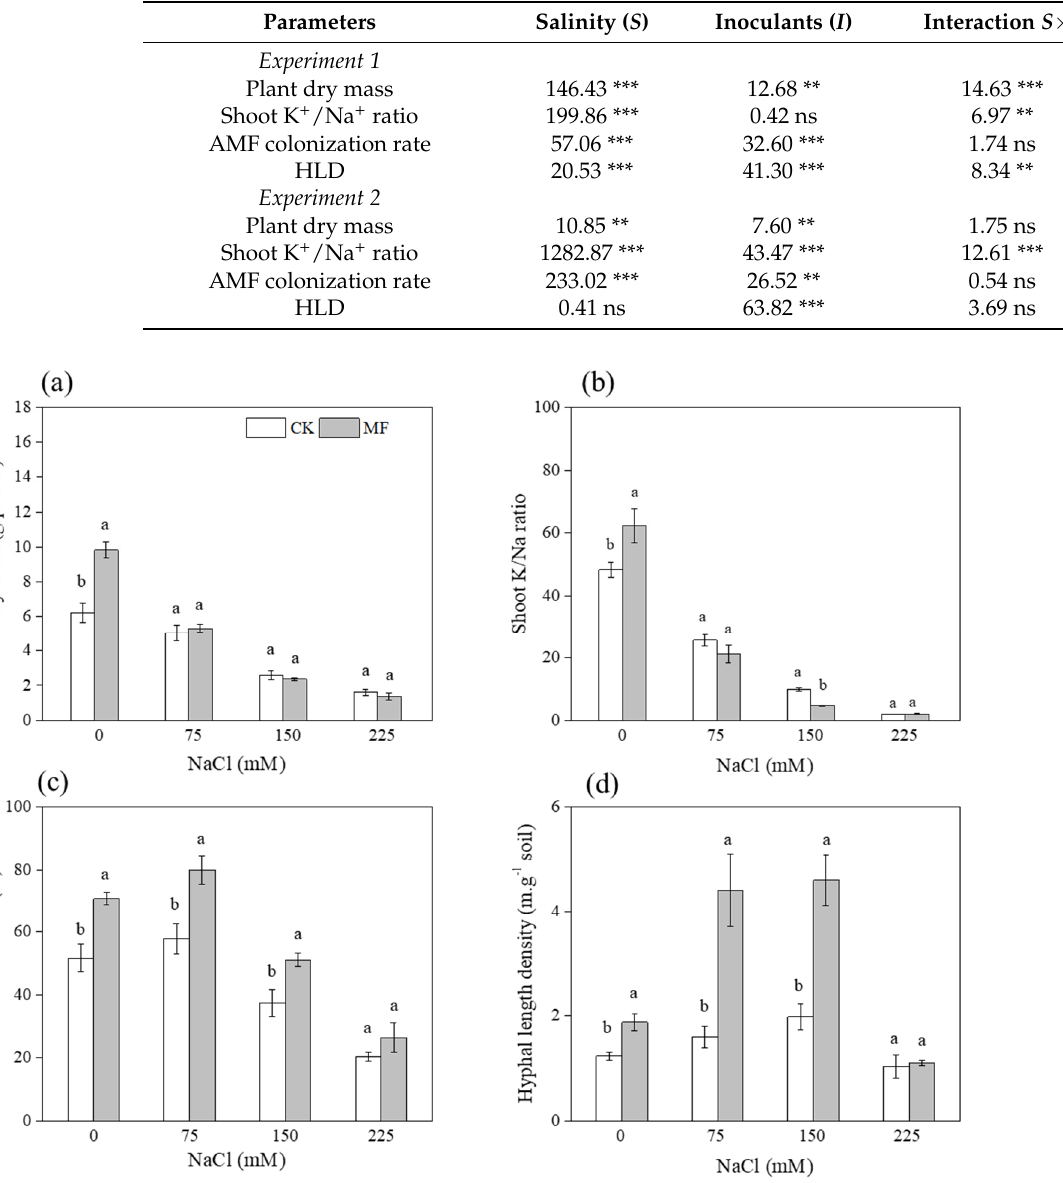
Table 1. Summary of statistical analysis testing the differences between salinity levels, inoculum types, and their interactions with plant dry mass, shoot K + /Na + ratio, AMF colonization rate, and hyphal length density (HLD) (experiment 1 and experiment 2). Three replicates per treatment combination are included. F -values are accompanied by indicators of statistical significance: *, p < 0.05; **, p < 0.01; ***, p < 0.001, and ns, non-significant.